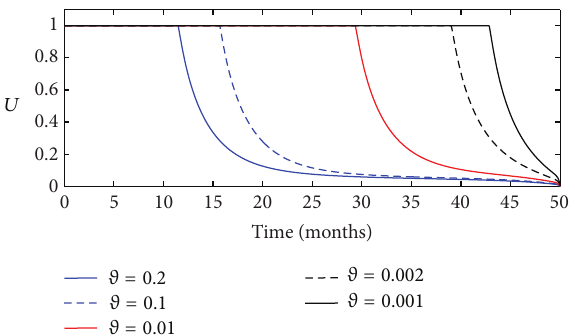
Figure 6: Graph of the numerical solutions to the behaviour of the control constraint, with the weight and cost factor 𝜗 being